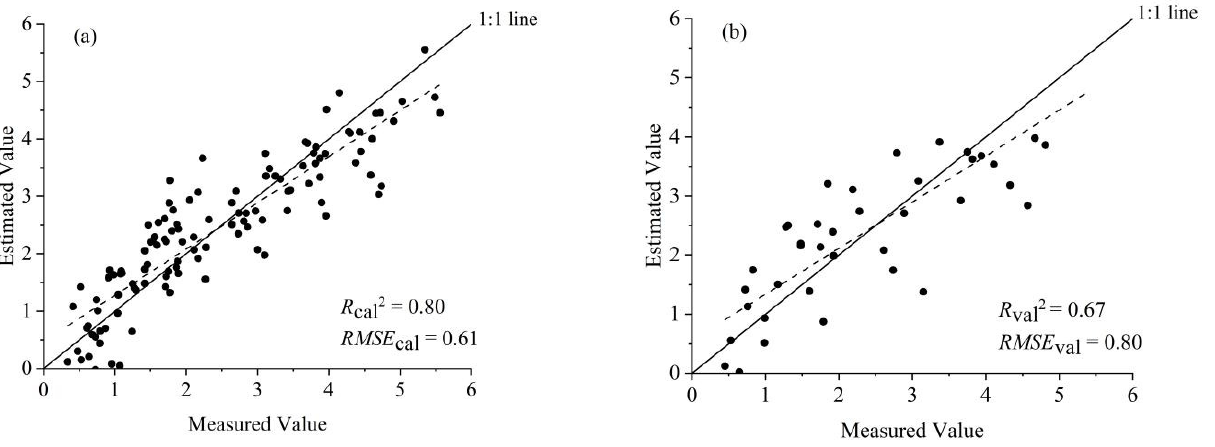
Figure 5. Cross-validation result for PLSR.